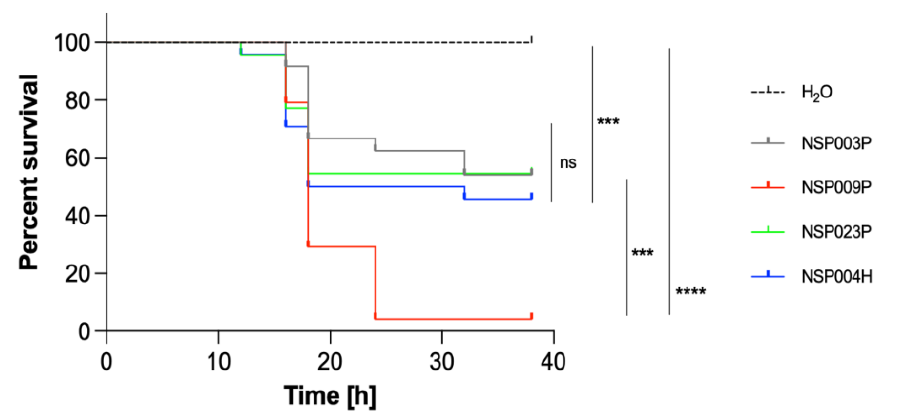
Figure 4. Virulence of S. pettenkoferi strains in zebrafish embryos. Kaplan–Meier representation of the survival of zebrafish embryos injured in the tail fin at 48 h post-fertilization (hpf) in a bath infected with S. pettenkoferi strains at 8 × 10 7 CFU/mL grown in exponential phase or “fish water” (negative control). Results are presented as the proportion of surviving embryos ( n = 24 for each, indicative of four separate experiments). Significant difference at *** p < 0.001, **** p < 0.0001 or no significant difference icant difference (ns).